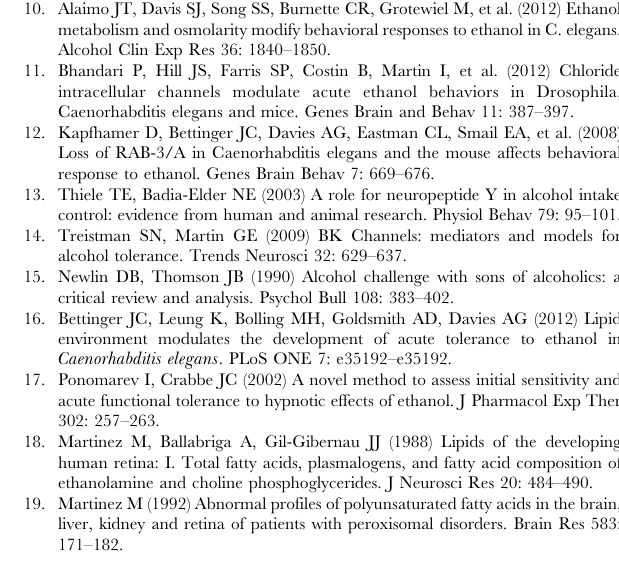
Table S1 Raw locomotion data for all experiments. The raw locomotion data that is used to generate the relative speed measurements is presented. Each experiment includes an exper- imental group and its paired controls, which were reared in identical conditions and tested on the same plates at the same time. The treated and untreated animals for a given experiment were tested on the same day. There is some day-to-day variation in the absolute speeds of animals. In addition, the presence of NP - 40 on the culture plates causes a general slowing of all genotypes of animals. In each case, the relative numbers that we present in the figures and text are derived from the experimental and their paired control animal